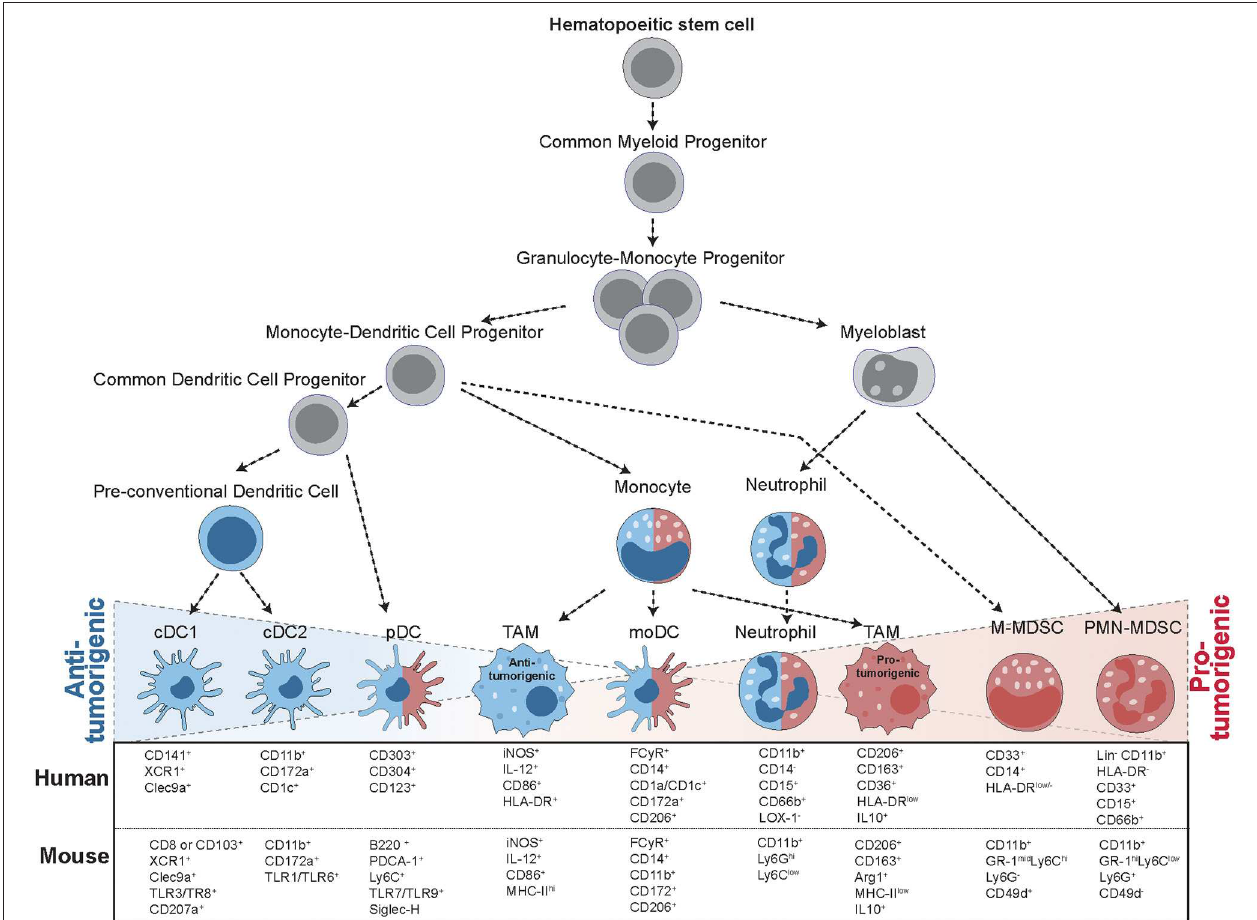
FIGURE 1 | Progression from hematopoietic stem cells (HSC) to tumor-infiltrating myeloid cells. The formation of tumor-infiltrating myeloid cells occurs in a step-wise process: In the bone marrow, HSCs give rise to common myeloid progenitors (CMP), which give rise to granulocyte-monocyte progenitors (GMP). GMPs then further specify into myeloblasts (MB) and monocyte-dendritic cell progenitors (MDP). These precursors then differentiate into a range of different cell types with anti-tumorigenic (blue) and pro-tumorigenic (red) capacities. MDPs can give rise to a common dendritic cell progenitor (CDP), further leading to the formation of conventional DCs (cDCs) or plasmacytoid (pDCs). MDPs also form monocytes, giving rise to monocytic DCs (moDCs) or differentiating into tumor-associated macrophages (TAMS) upon instruction by the tumor. Macrophages can display multiple different activation states, ranging from anti-tumorigenic to pro-tumorigenic subsets. MBs give rise to mature neutrophils or polymorphonuclear myeloid-derived suppressor cells (PMN-MDSCs), while monocytic MDSCs (M-MDSCs) arise from MDPs upon instruction by inflammatory signals. All of these cell types are characterized by specific surface marker expression, indicated for both human and mouse